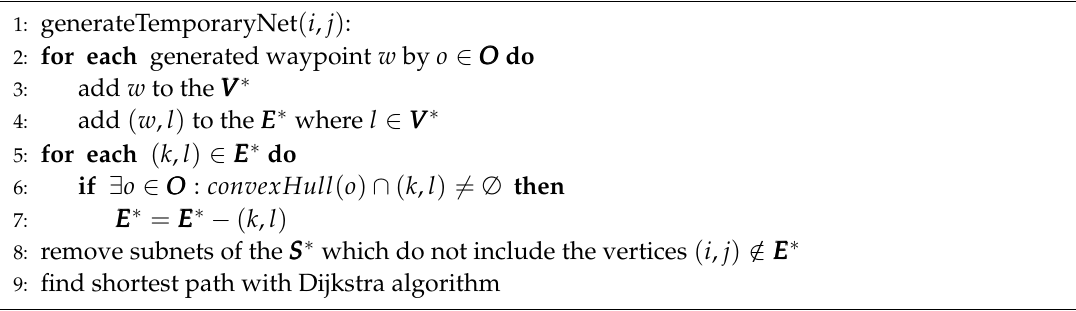
Algorithm 4 Temporary net generation and precise path